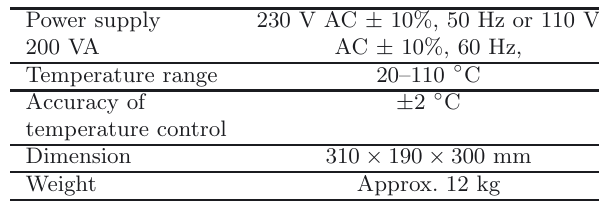
Table 2. Specifications of Oil Test Cell Heater.